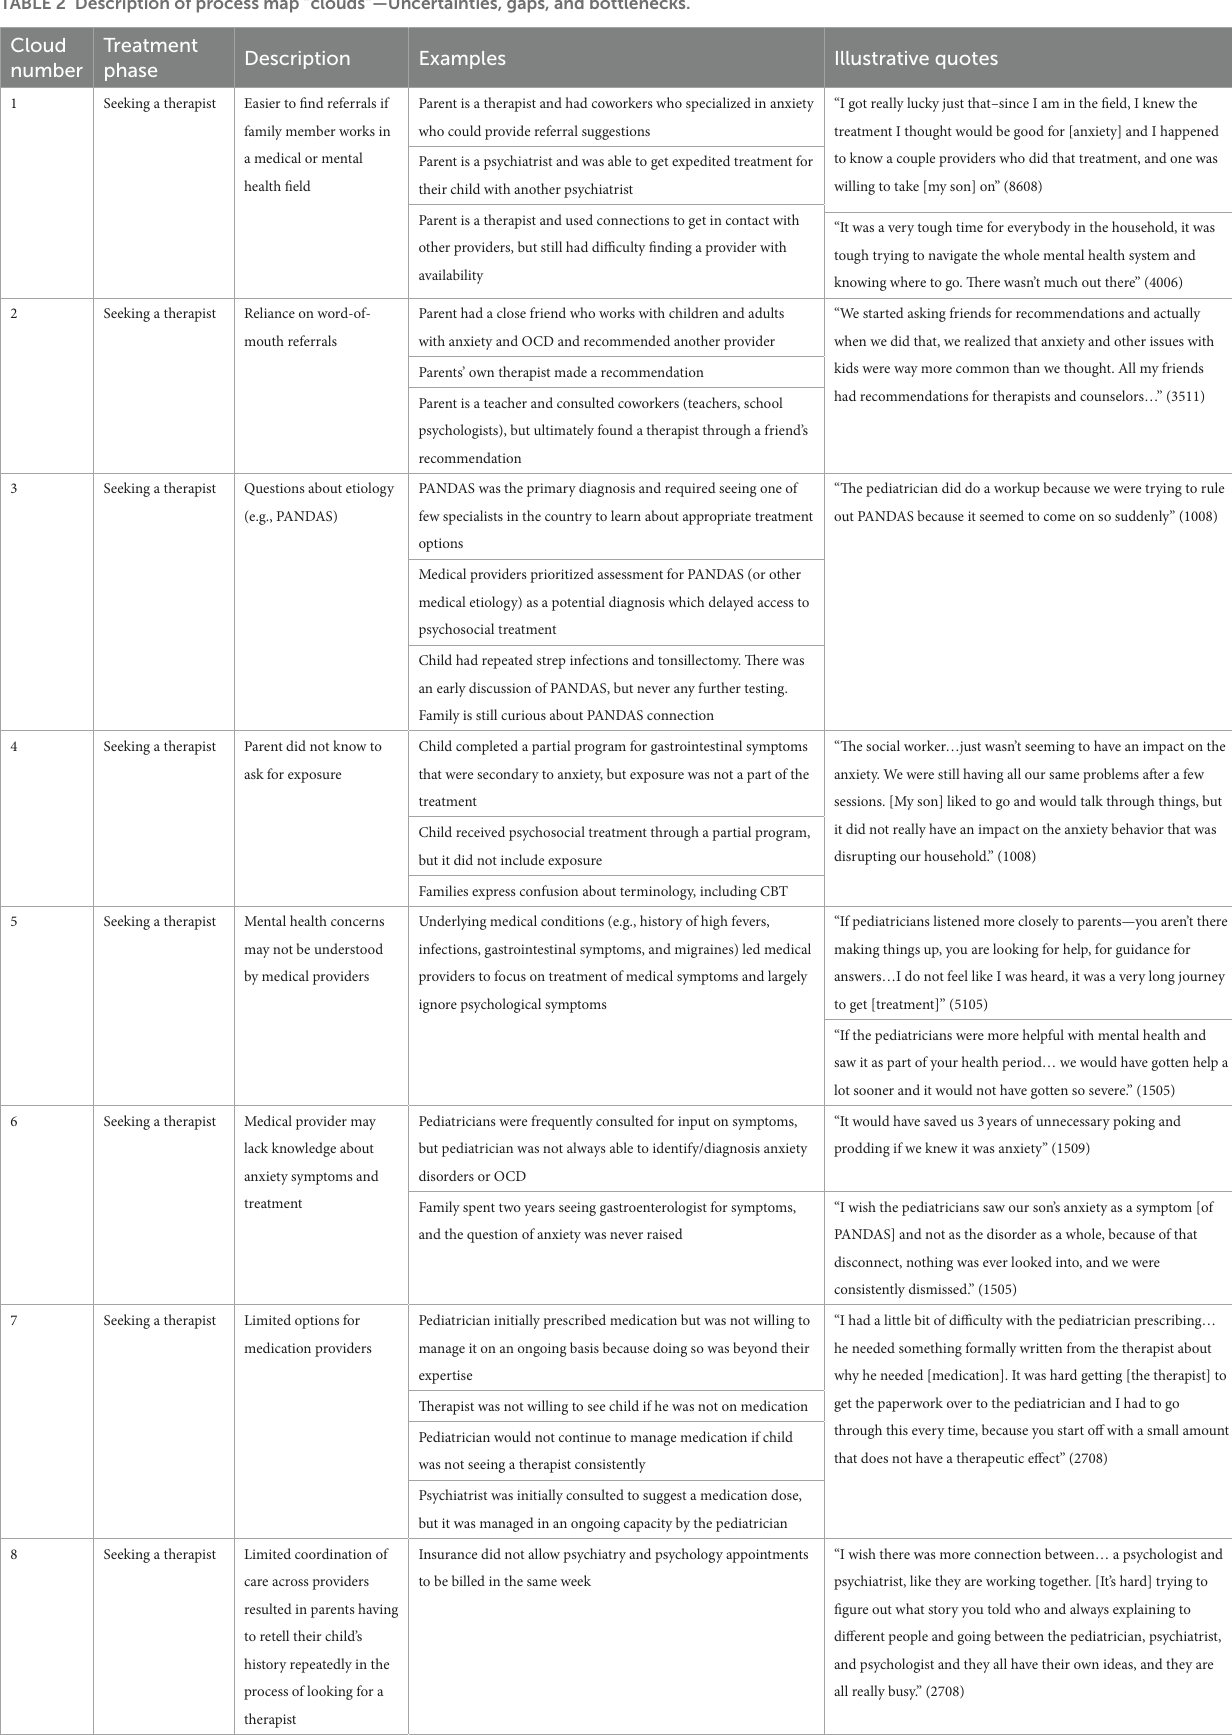
TABLE 2 Description of process map “clouds”—Uncertainties, gaps, and bottlenecks. Cloud Treatment number phase